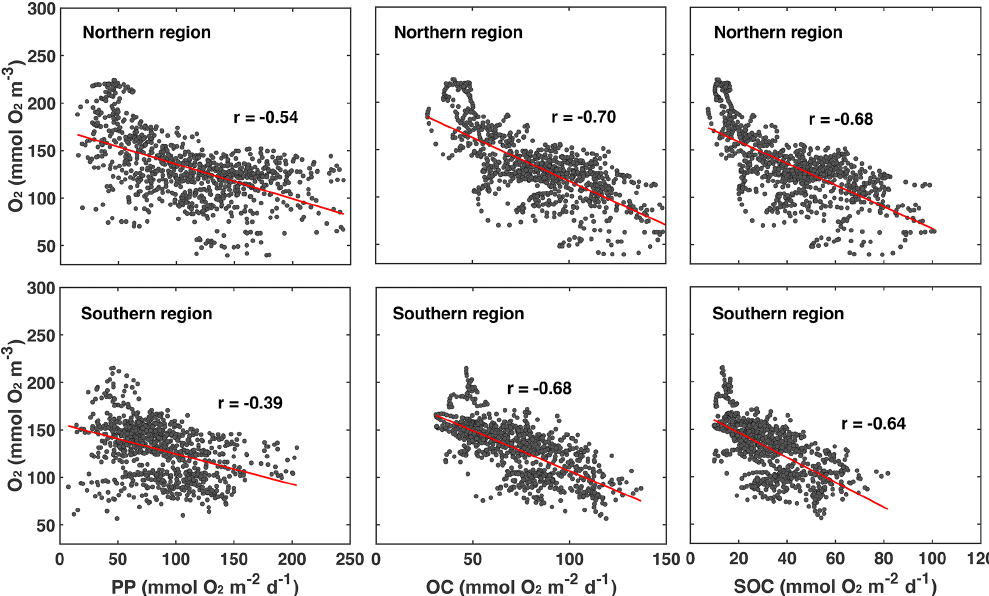
Figure 7. Correlations of daily averaged rates of PP, OC, and SOC plotted with daily mean bottom oxygen concentration in the northern and southern regions of the low-oxygen zone in summer. The correlations are all significant. Correlation coefficients and slope and intercept of linear regressions (indicated by red lines) are given in Table